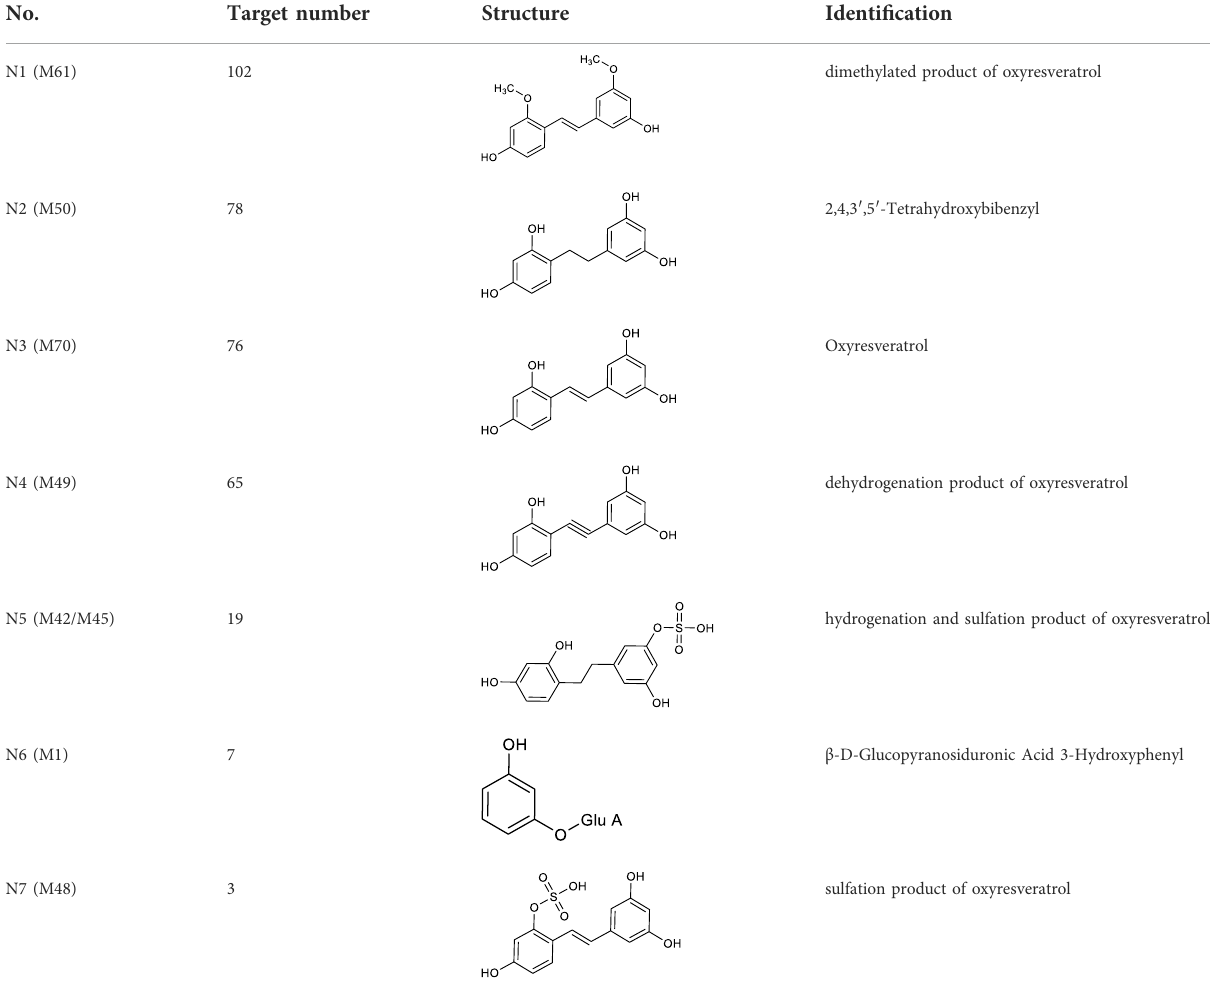
TABLE 2 Target information of 7 metabolites of mulberroside A.